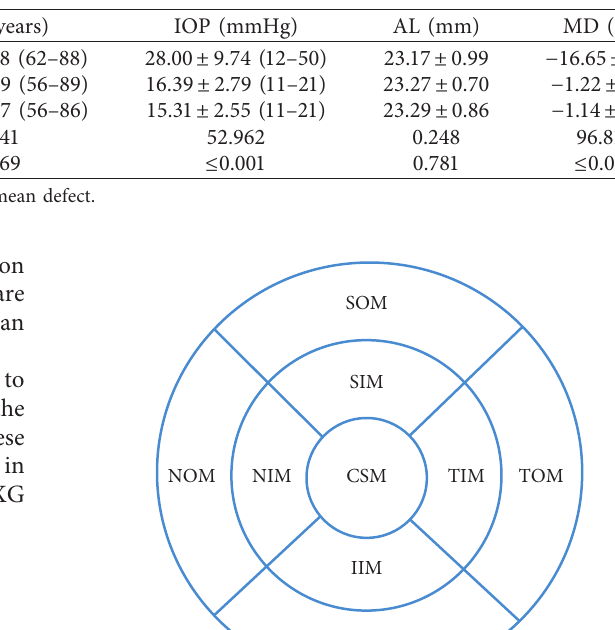
Table 1: Baseline characteristics of the study groups.